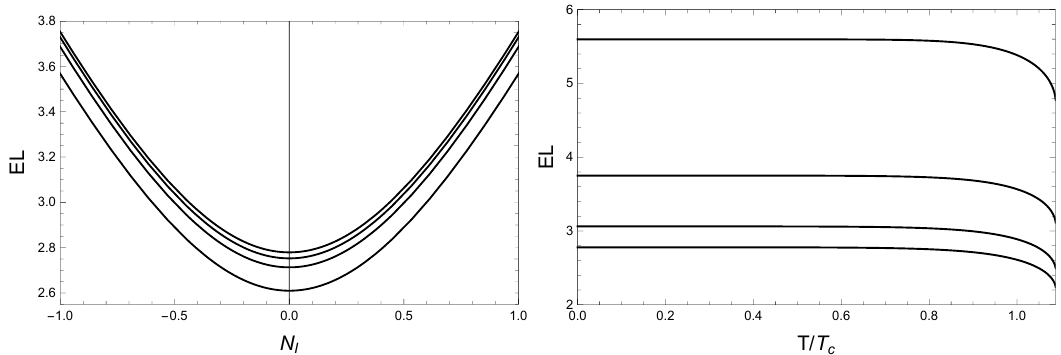
Figure 7: Single-baryon energy as a function of the isospin number for different tempera- = 0,0.8,0.9,1 from top to bottom, and as a function of temperature tures (left panel), T / T c = 0,0.5,1,2 from bottom to top. The energy for different isospin numbers (right panel), N I is given in units of the inverse asymptotic separation of the flavor branes L − 1 , while T is c the critical temperature for the chiral phase transition, and we have set λ/(cid:96) = 20. In the semi-classical approximation of this paper, the spectrum is continuous in N I